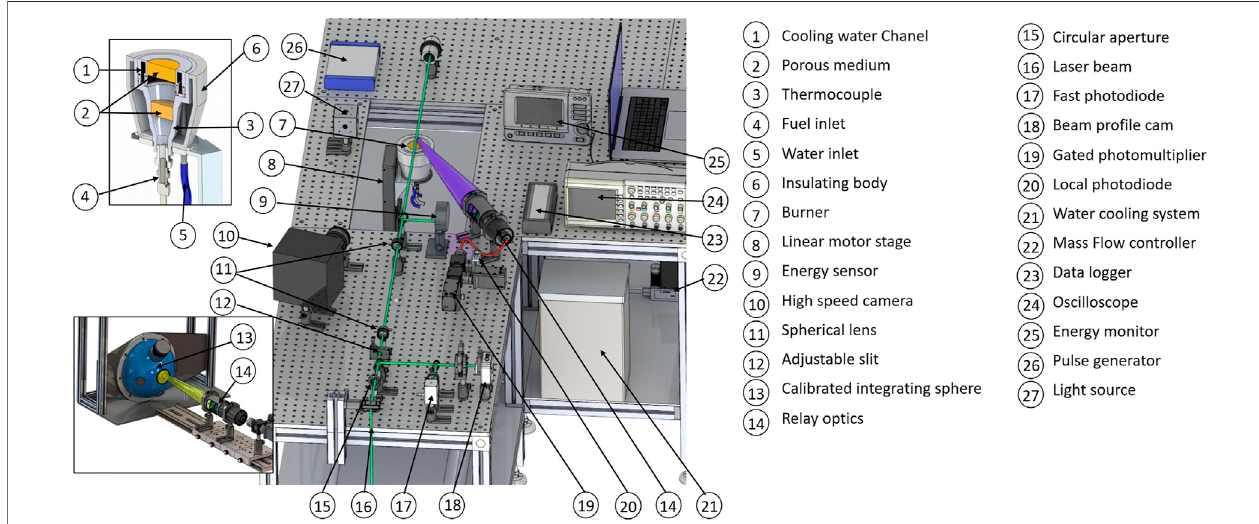
FIGURE 1 | Schematic of the optical rig for AC-LII signal and fl ame intensity measurements, pool burner details and devices for optical calibration.